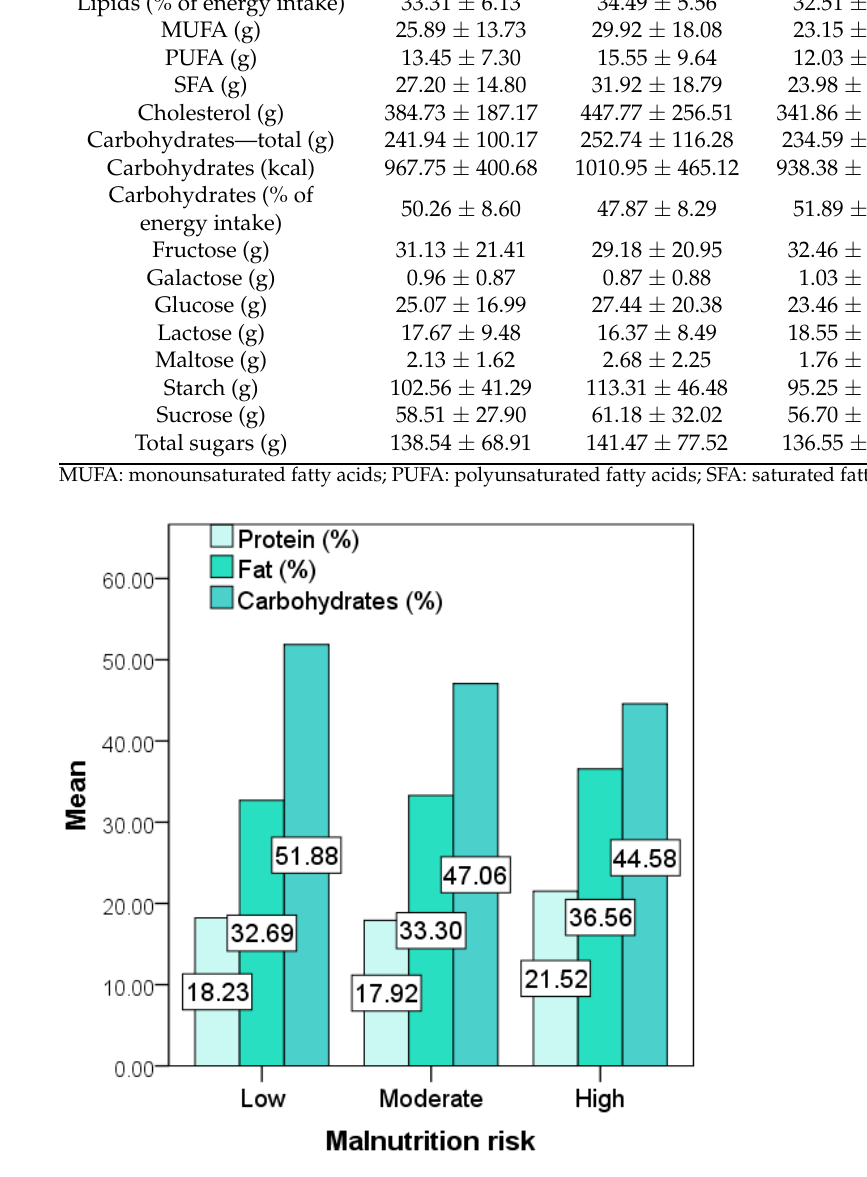
Figure 2. Macronutrient energy contributions with respect to malnutrition risk (MUST). The subjects who reported sleeping less than 7 h/day on a regular basis consumed significantly larger amounts of saturated fats ( p = 0.040), as well as total fat (expressed as % of the daily caloric intake; p = 0.024) and sugars ( p = 0.022). Total serum protein levels were significantly associated with the mean intakes of di- etary proteins ( r = 0.330, p = 0.033).